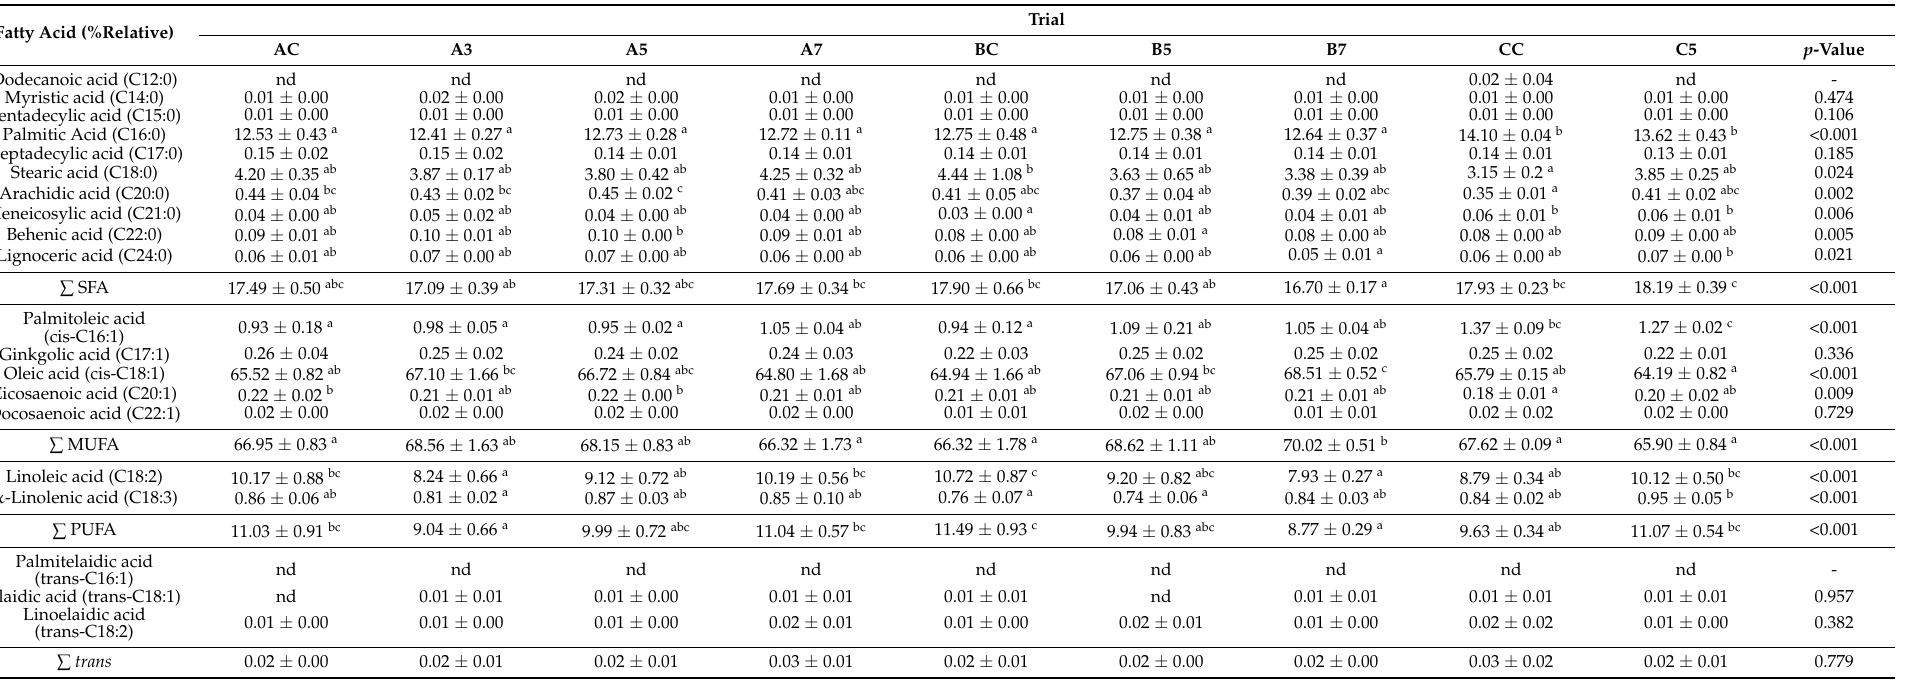
Table 5. Fatty acid profile (% relative of total peak area) of Cobrançosa table olives under the different